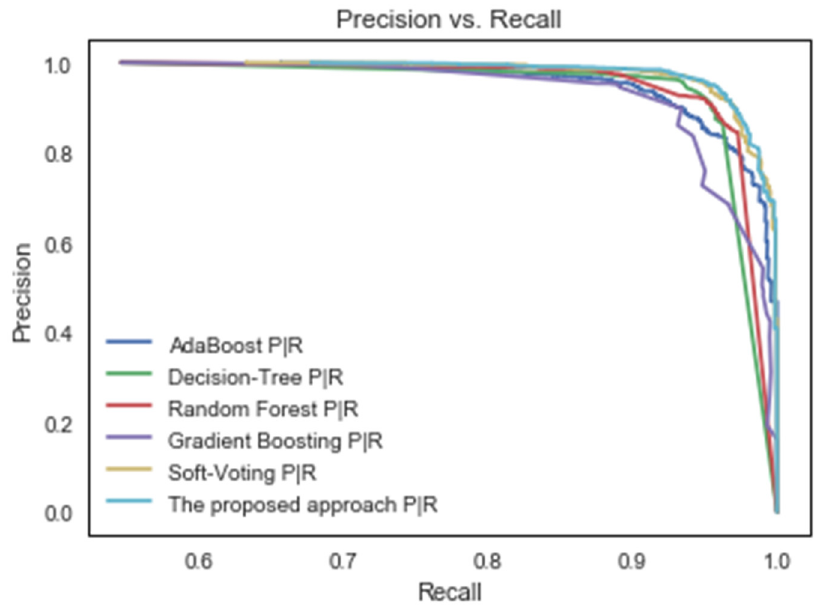
Figure 5. Precision–recall curves of the suggested classifier and some machine learning techniques.